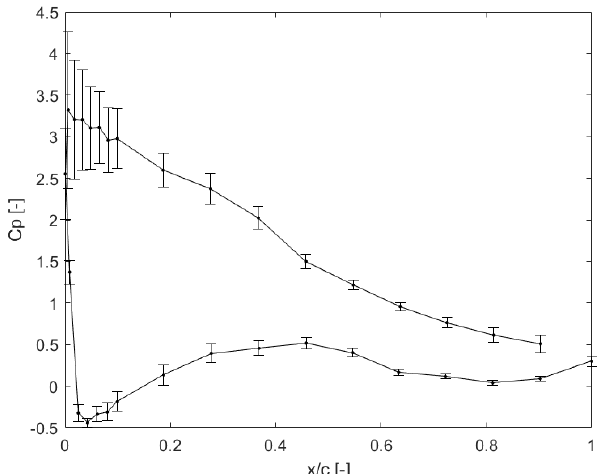
Figure 9. Example of measured average pressure coefficient at sec- tion S2 of the tip for one case at 5 ◦ pitch. Error bars indicate stan- dard deviation.